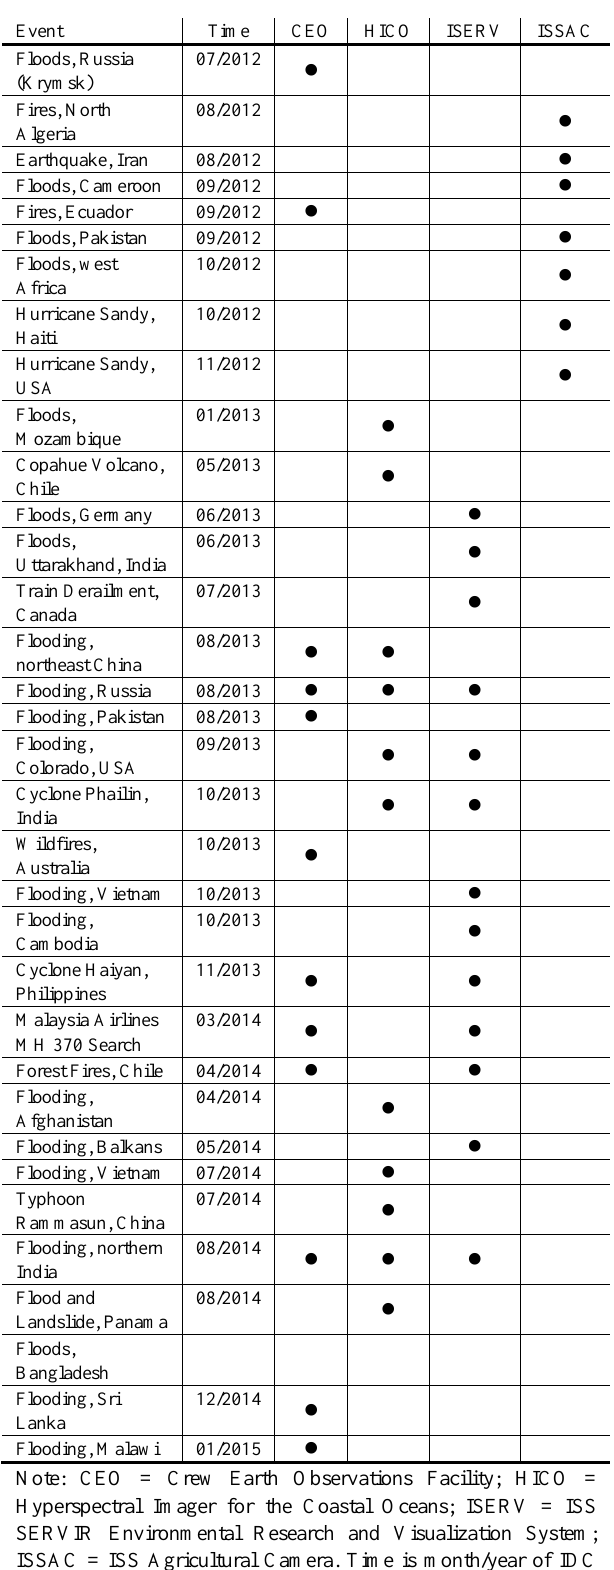
Table 1. IDC Data Collection by NASA ISS Sensor Systems Event Time CEO HICO ISERV